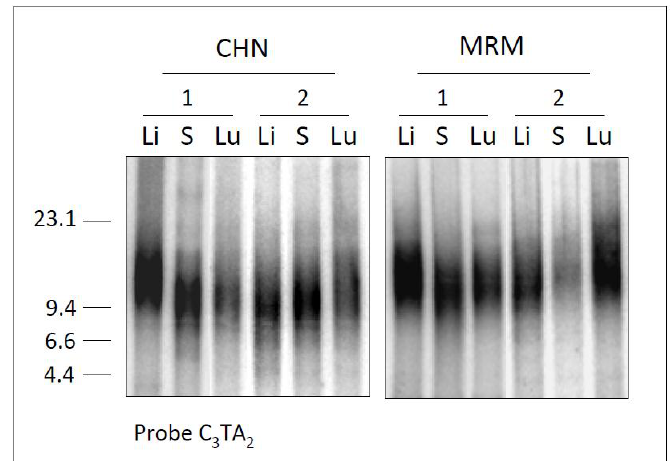
Figure 2. Telomere length in CHN and MRM samples. Genomic DNAs from liver (Li), spleen (S) and lung (Lu) of two Chianinas (CHN 1 and 2) and two Maremmanas (MRM 1 and 2), were digested, separated by FIGE and hybridized to the telomeric probe (C M,  Hind III size marker (in